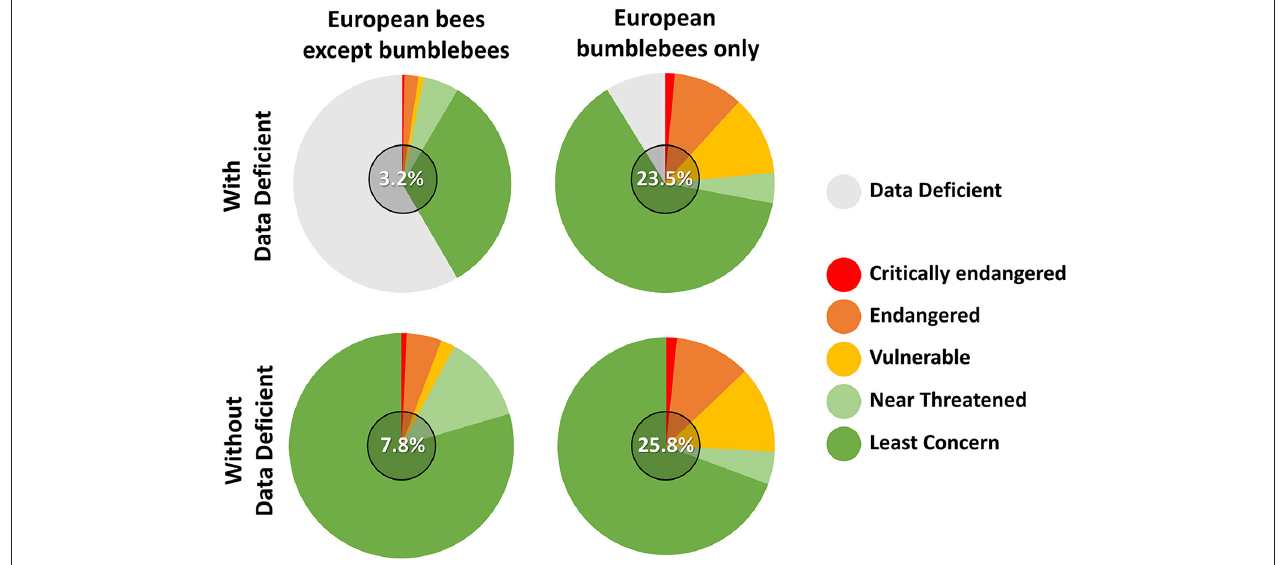
FIGURE 1 | IUCN Red List status of the bees of Europe following Nieto et al. (2014) separating bumblebees from all other bees and including or not bees falling in the “Data Deficient” category. Numbers in the middle of the pie charts correspond to the percentage of threatened species (i.e., vulnerable, endangered and critically